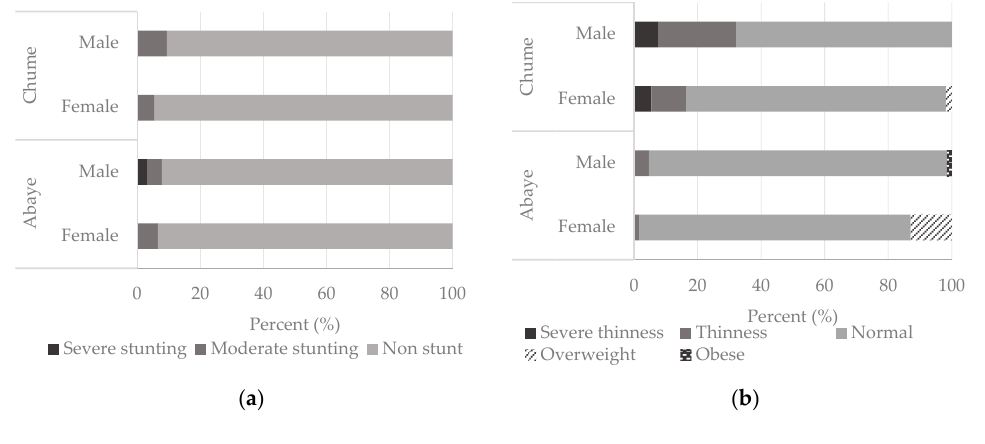
Figure 2. Adolescent ( a ) stunting and ( b ) thinness.